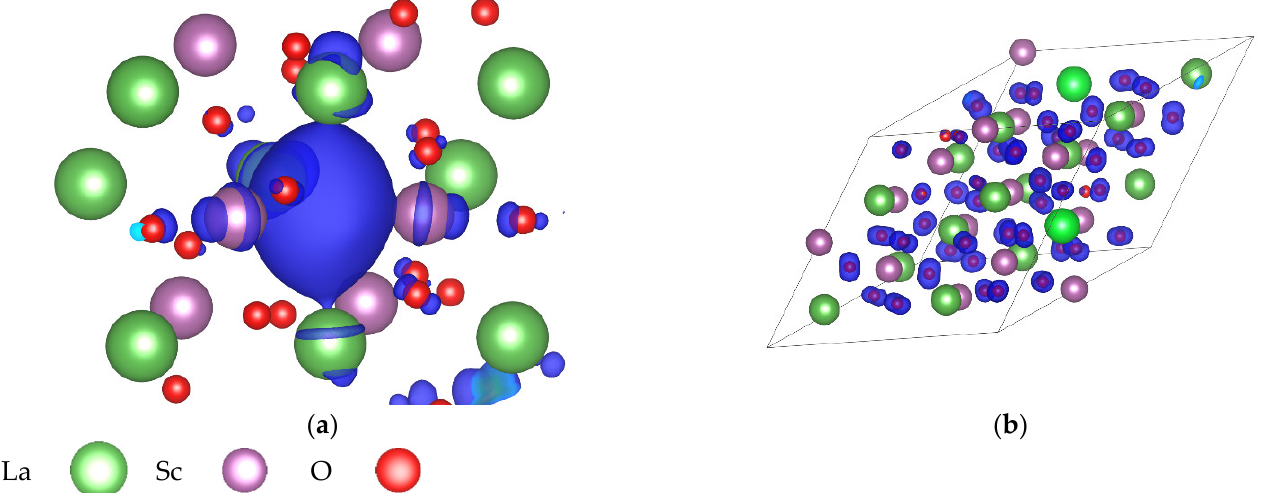
Figure 4. Orbital-projected electron density of F 0 -, F + - and F ++ -centres ( a ) and electron holes on oxygen p -orbitals ( b ).